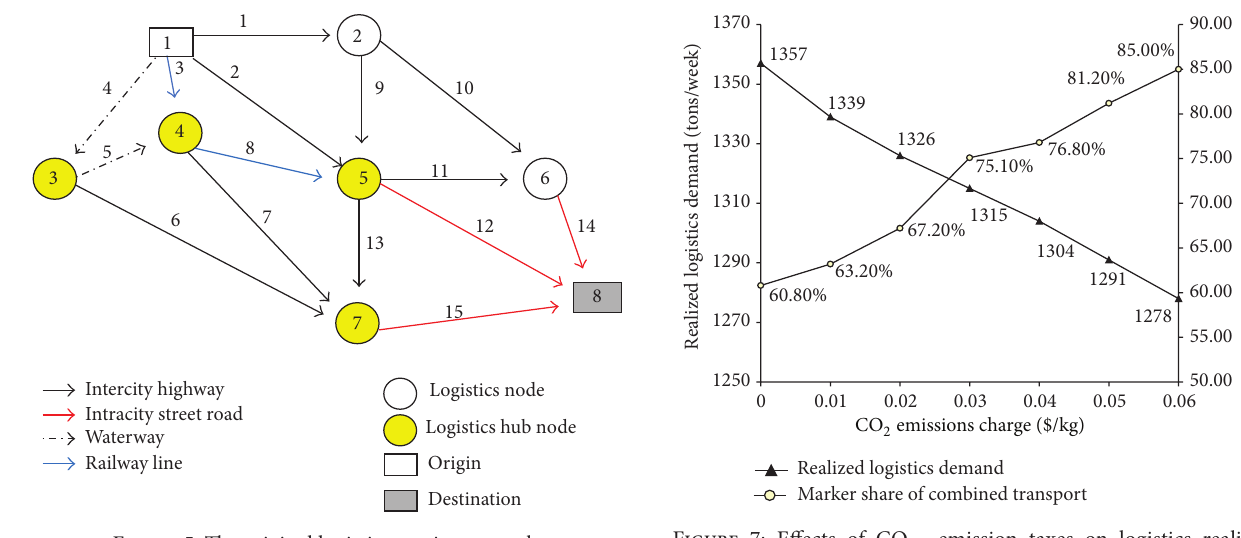
Figure 5: The original logistics service network.